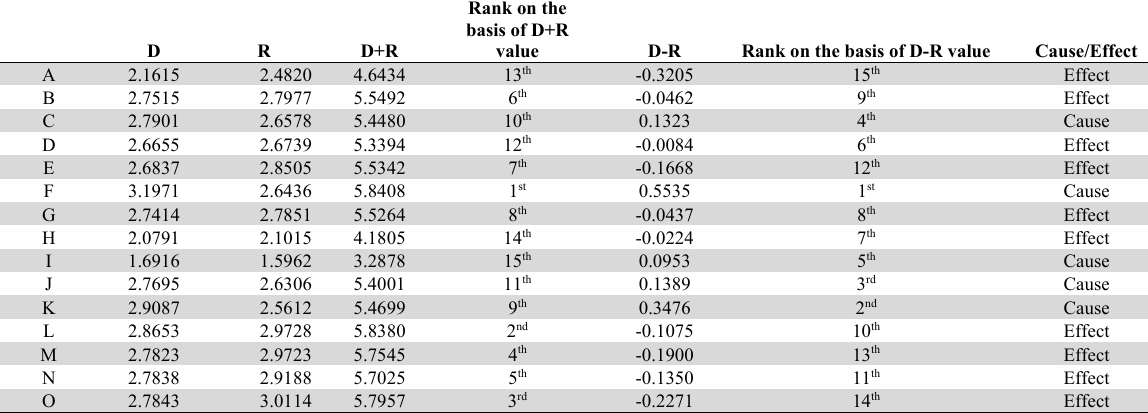
Final output of F-DEMATEL